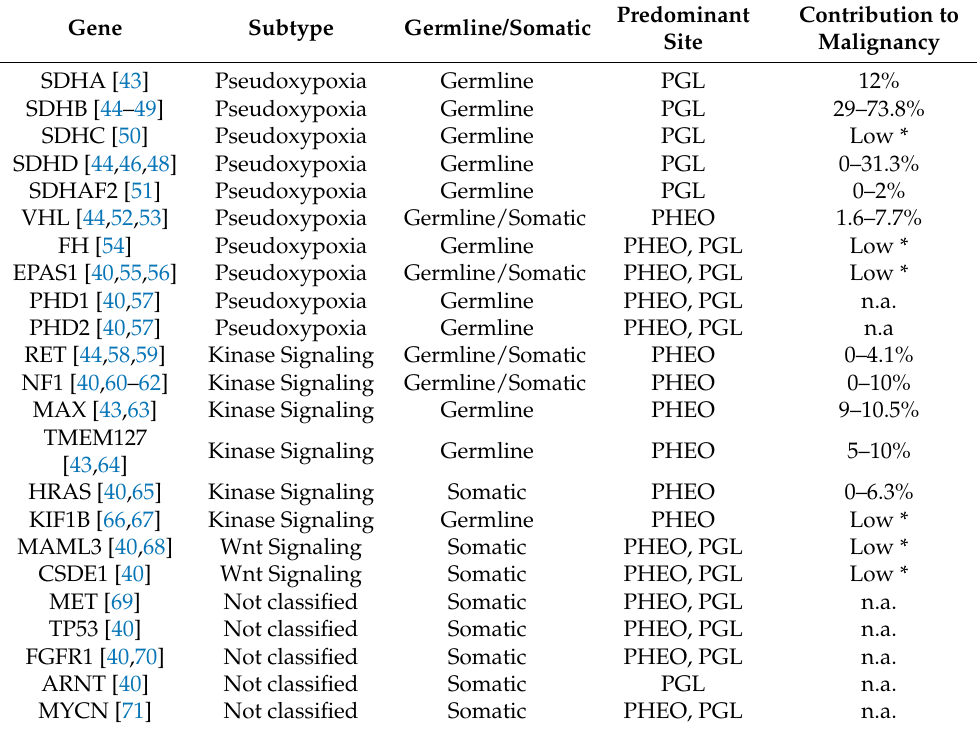
Table 1. Genes associated with